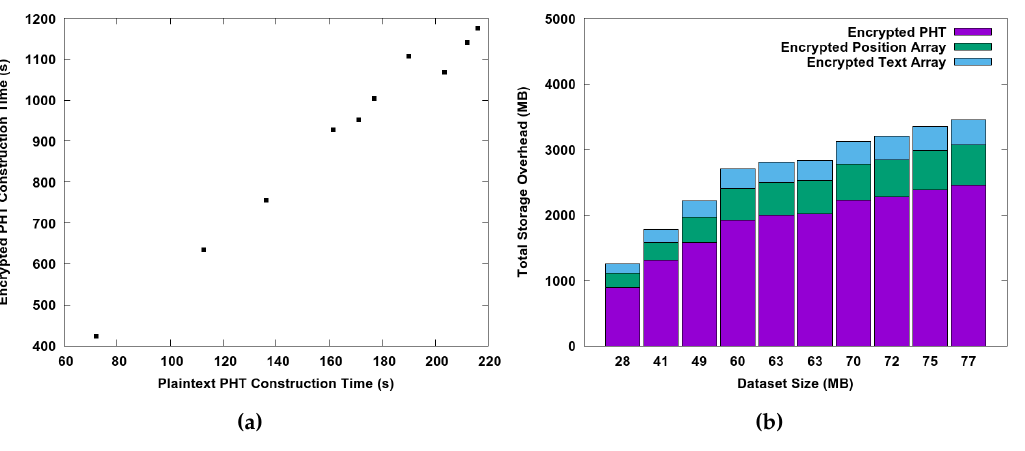
Figure 5. Experimental results. ( a ) The construction of the position heap tree; ( b ) the searchable index